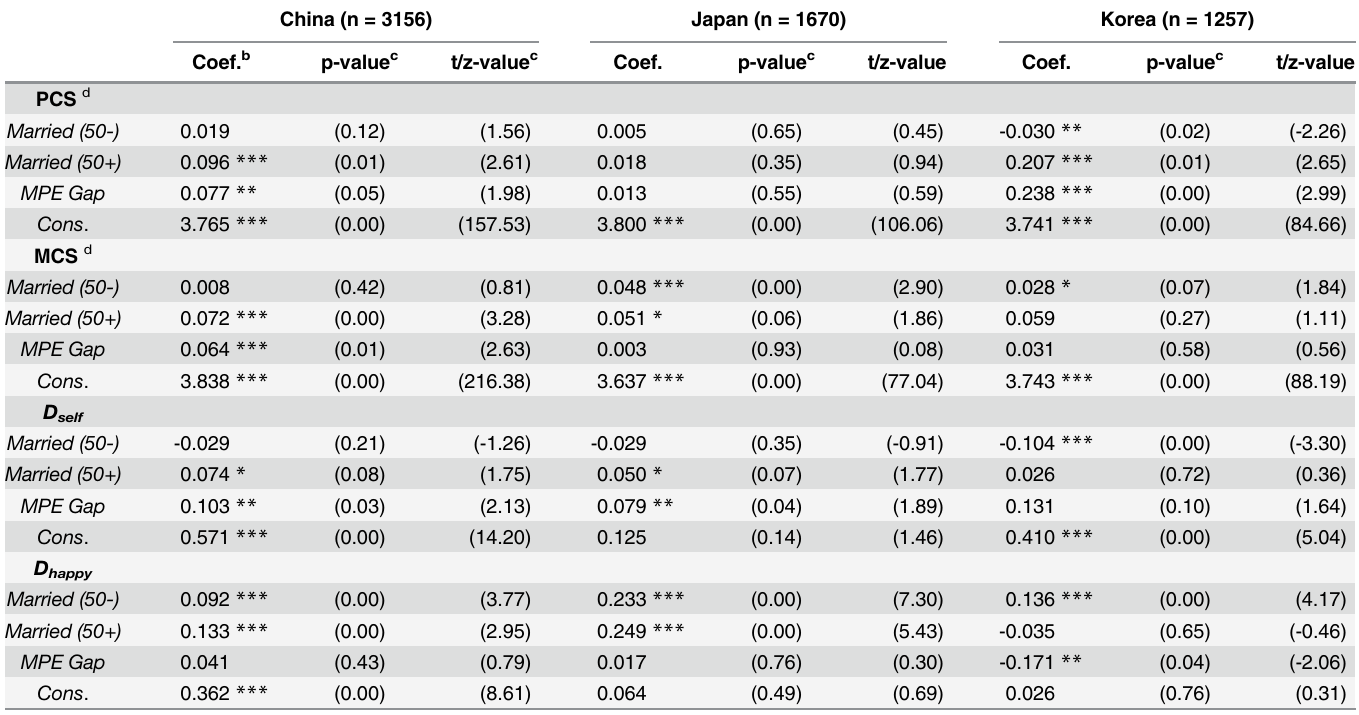
Table 3. Marriage Protection Effect by Generation a